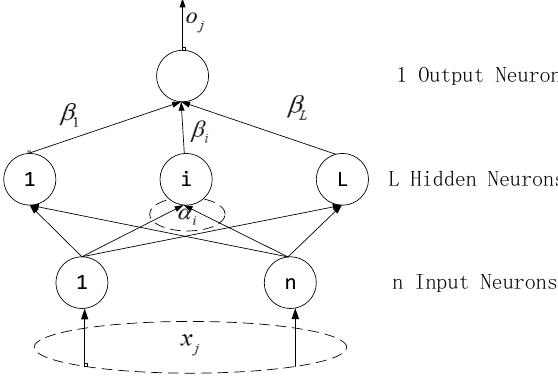
Figure 14. Single hidden layer extreme learning machine (ELM) structure.